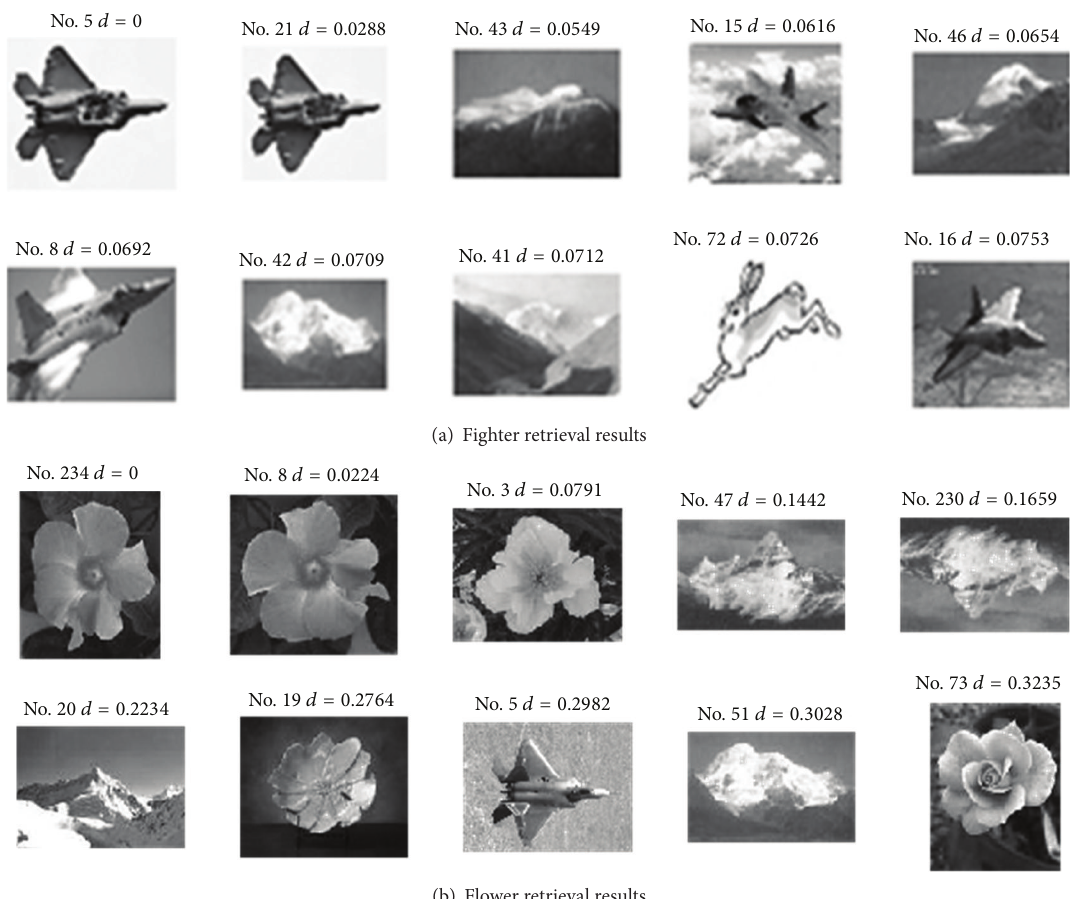
Figure 8: Retrieval results for EDH.